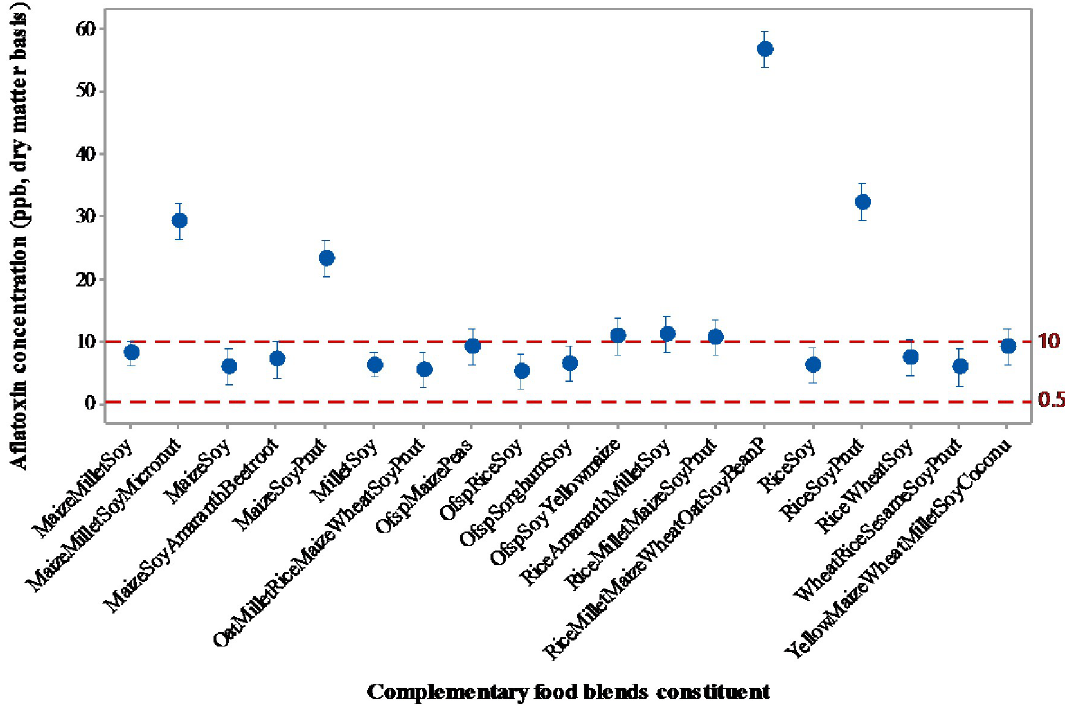
Fig 3. Aflatoxin concentration of commercial complementary